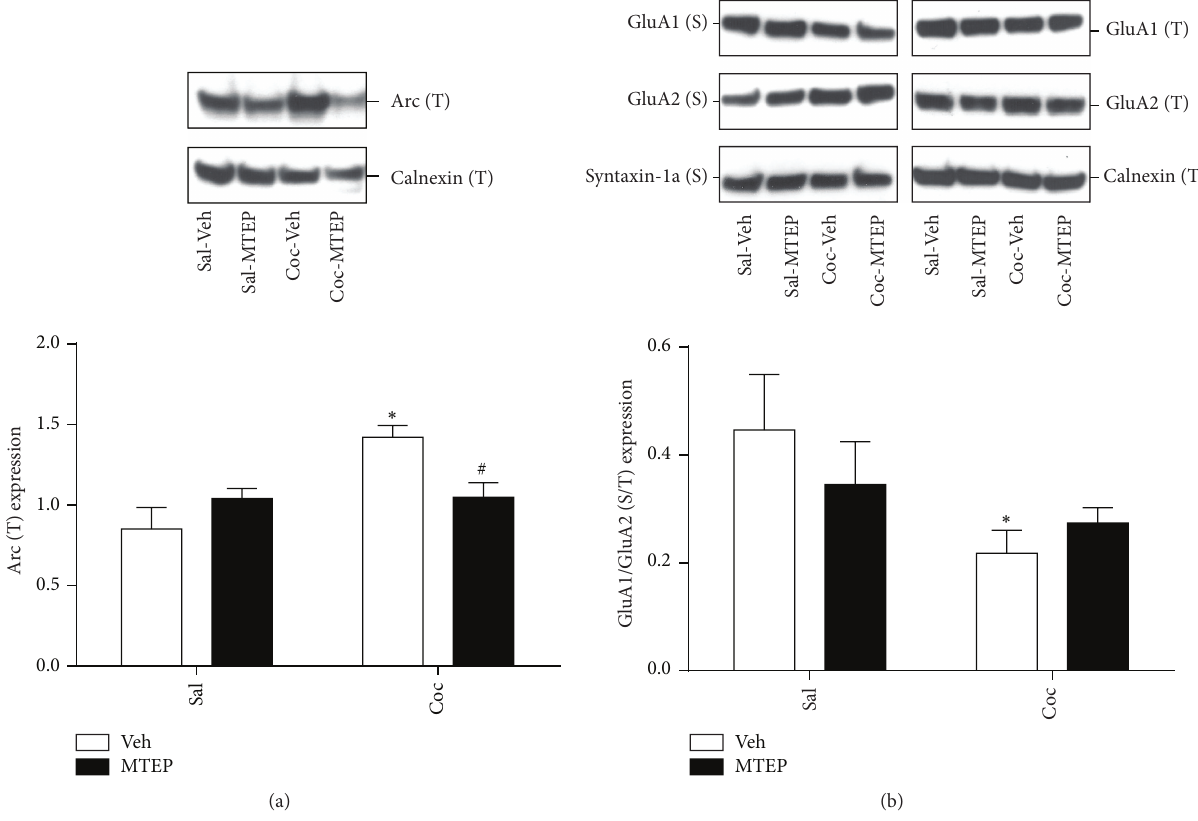
Figure 4: The expression of Arc and the ratio of GluA1/GluA2 surface expression are altered by cocaine history and intra-dlSTR administration of MTEP. (a) Arc expression was significantly increased by cocaine and this effect was prevented in rats that were treated with intra-dlSTR MTEP prior to the relapse test. (b) The ratio of GluA1/GluA2 was reduced significantly in Veh-treated cocaine rats relative to Veh-treated Sal control rats. ∗ 𝑝 < 0.05 compared to Sal-Veh. # 𝑝 < 0.5 compared to